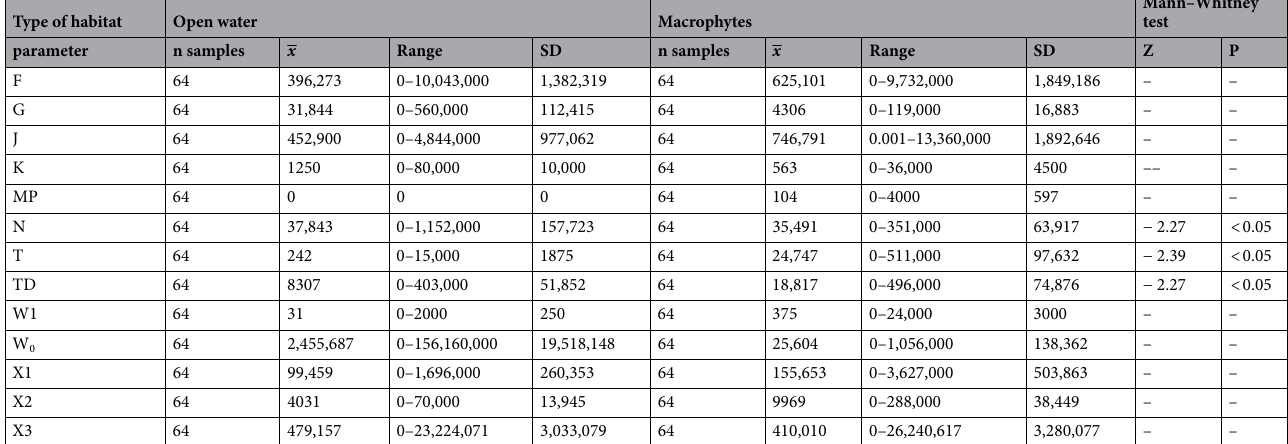
Table 6. Abundance of each chlorophyte functional group (ind l −1 ) in different pond habitats (open water vs. macrophyte-dominated zone). The results of Mann–Whitney test are